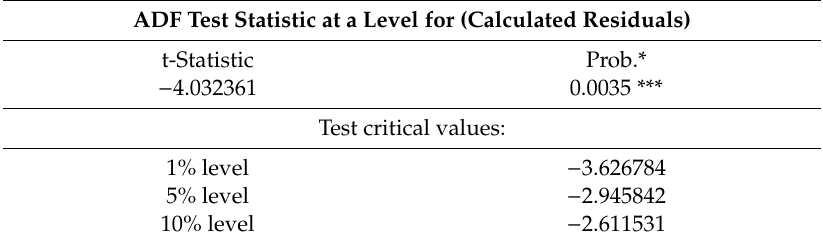
Table 7. First step in Engle-Granger cointegration test to calculating the residuals unit root. ADF Test Statistic at a Level for (Calculated Residuals) t-Statistic Prob.* − 4.032361 0.0035